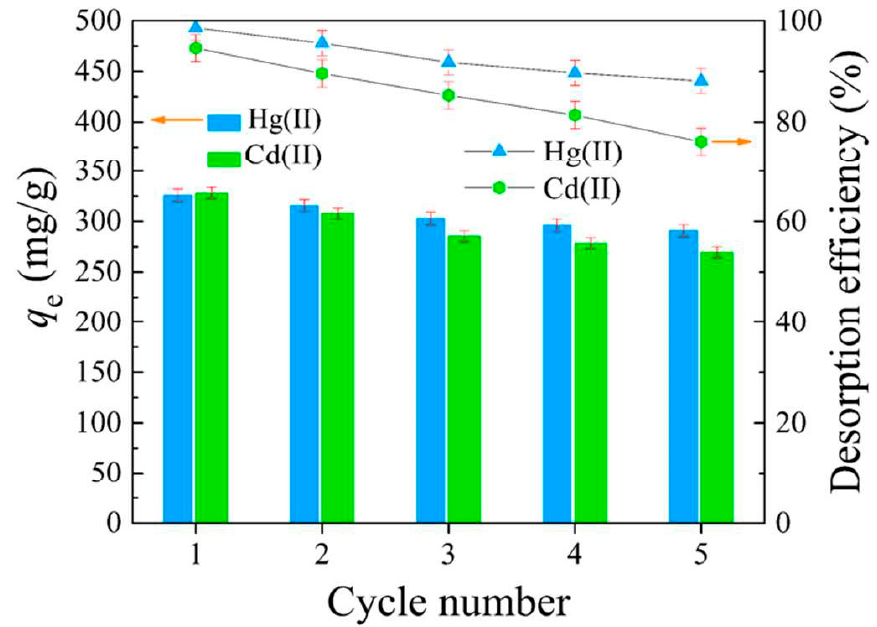
Figure 13. Adsorption capacities of Hg 2+ and Cd 2+ on PANMW-Thiol fiber regeneration. Reproduced with permission from reference [32].